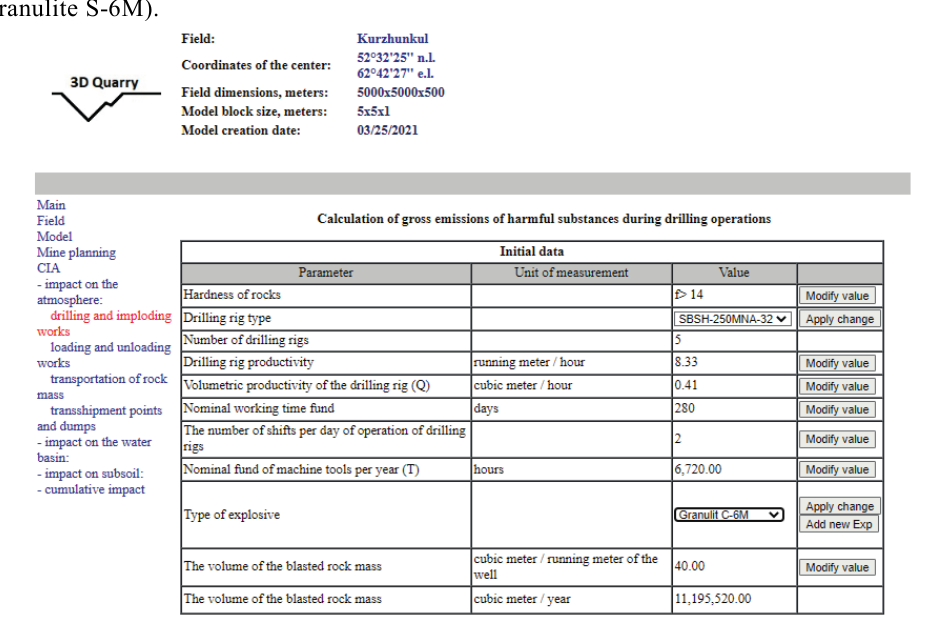
Fig. 1. Calculation of gross emissions of harmful substances during drilling operations (initial